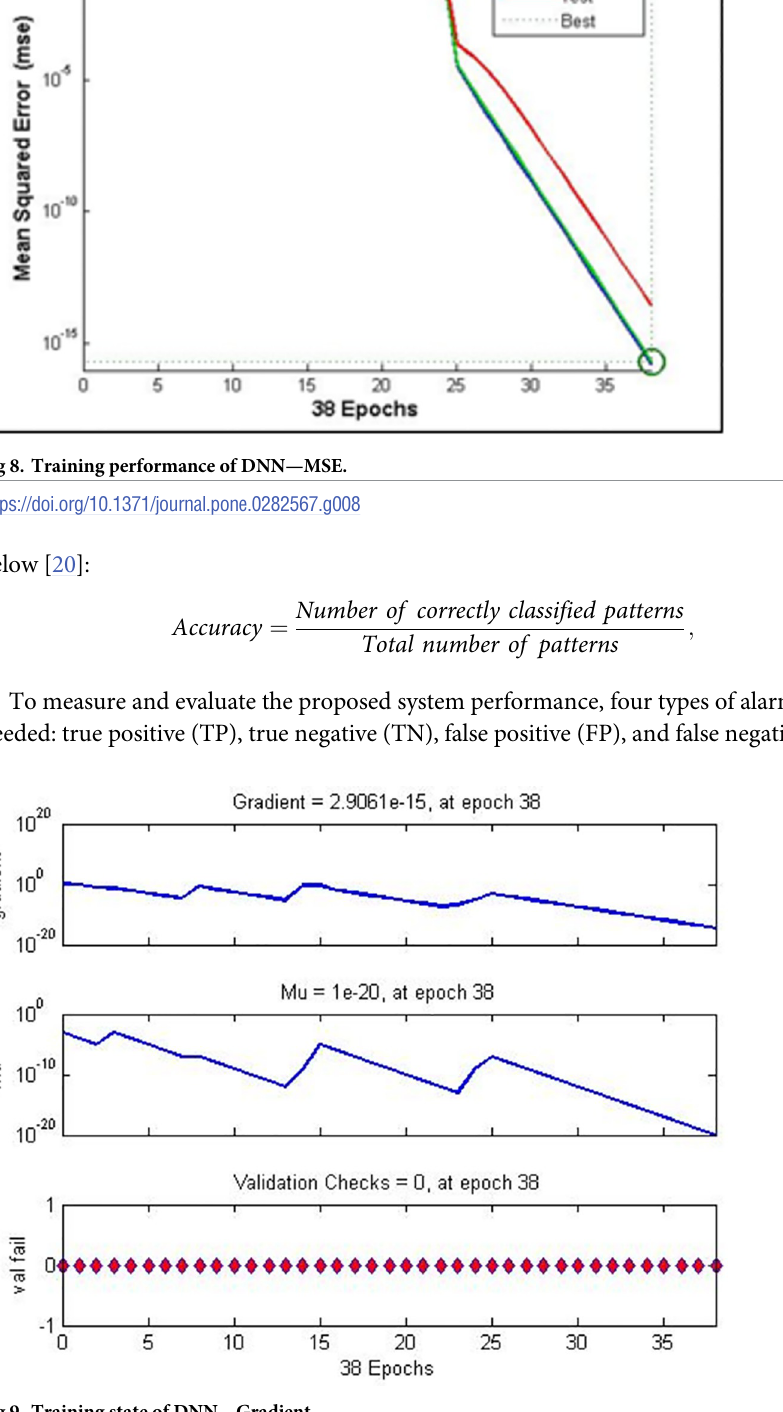
Fig 9. Training state of